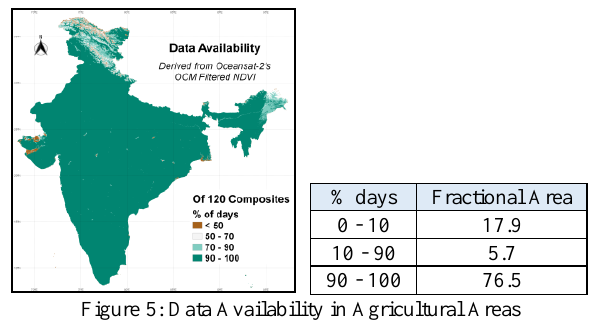
Figure 5: Data Availability in Agricultural Areas